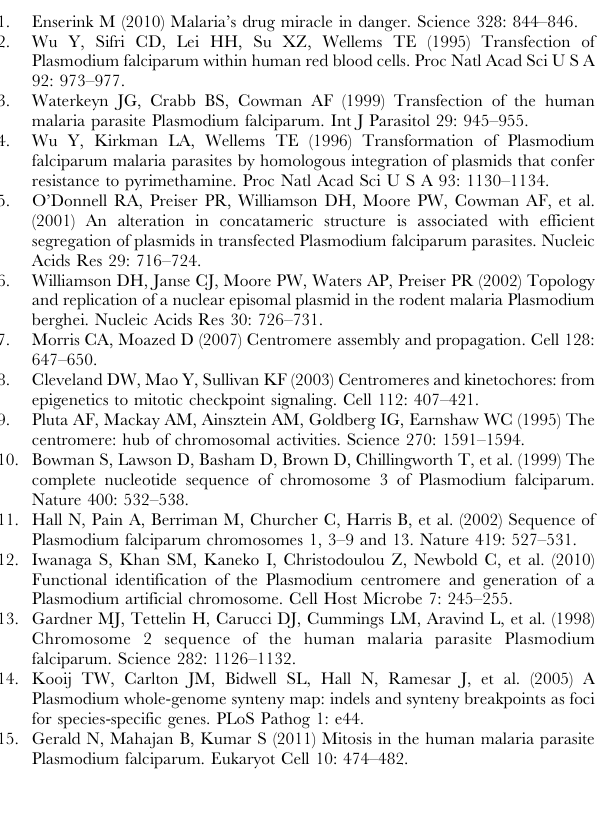
Table S1 Sequence properties of centromeres of Plasmodium spp including P. falciparum , P. vivax , P. berghei and P. yoelii